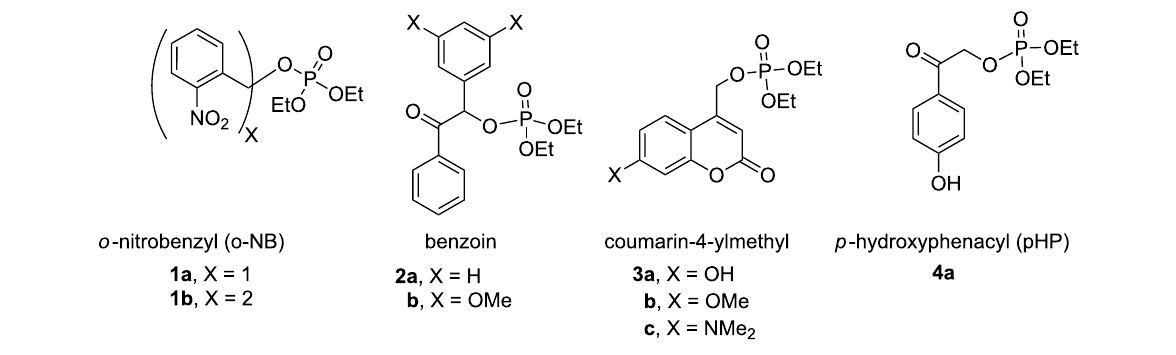
Figure 1: Common photoremovable protecting groups (PPGs) for phosphates depicted as diethyl phosphate (DEP) esters.